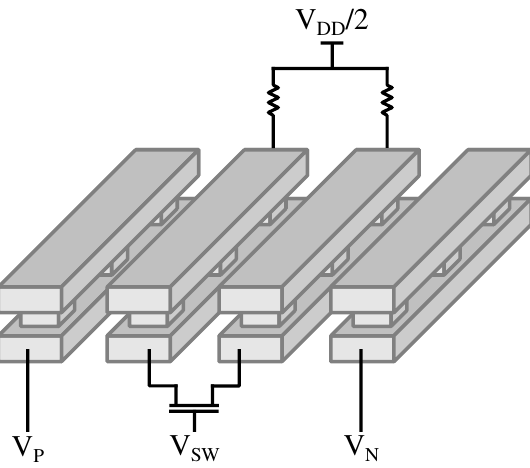
Figure 5. The implementation of the tracking bank custom MOM capacitor cells. Digital control of the cell capacitance is implemented by electrically connecting the innermost two fingers using an NMOS